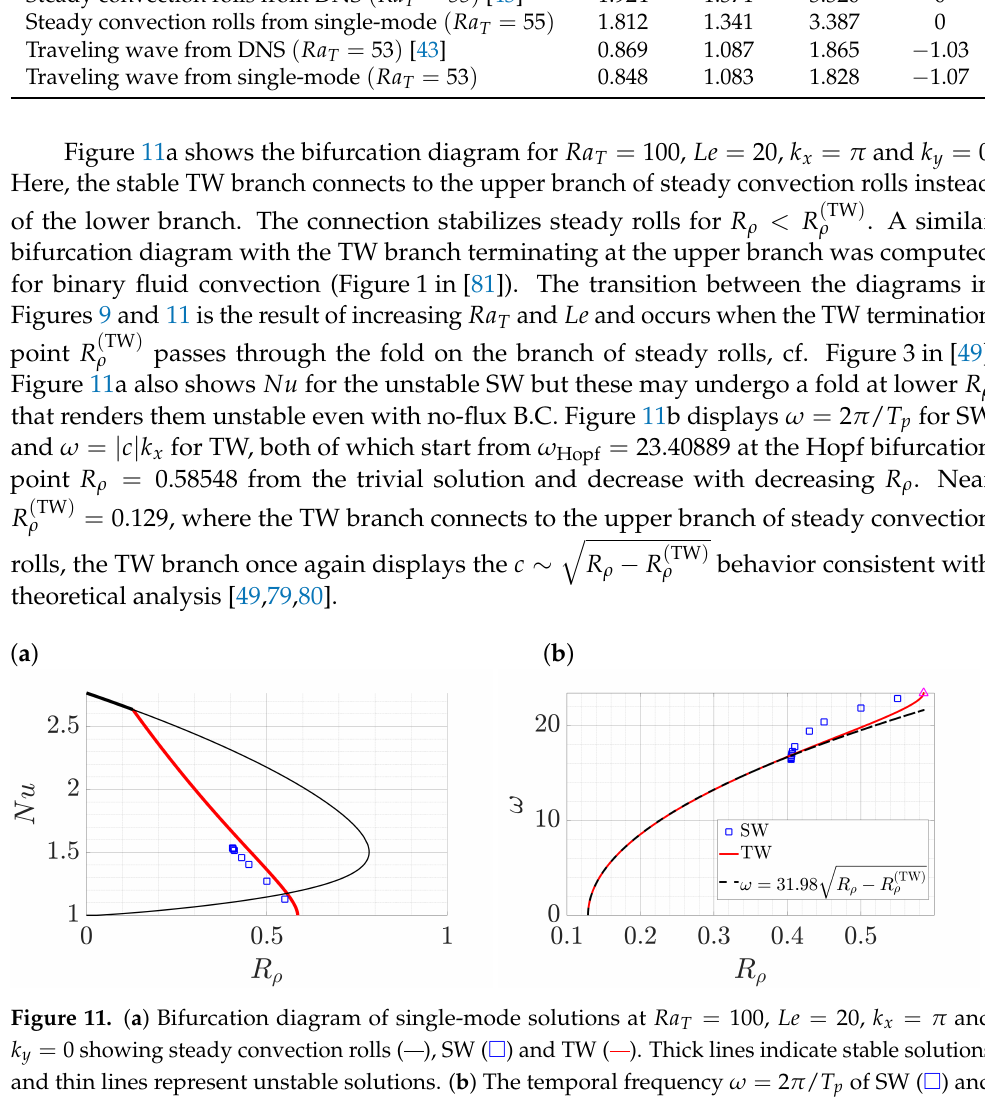
(cid:113) ( TW ) ( TW ) ∼ R ρ − R ρ as c ρ ( ) as predicted